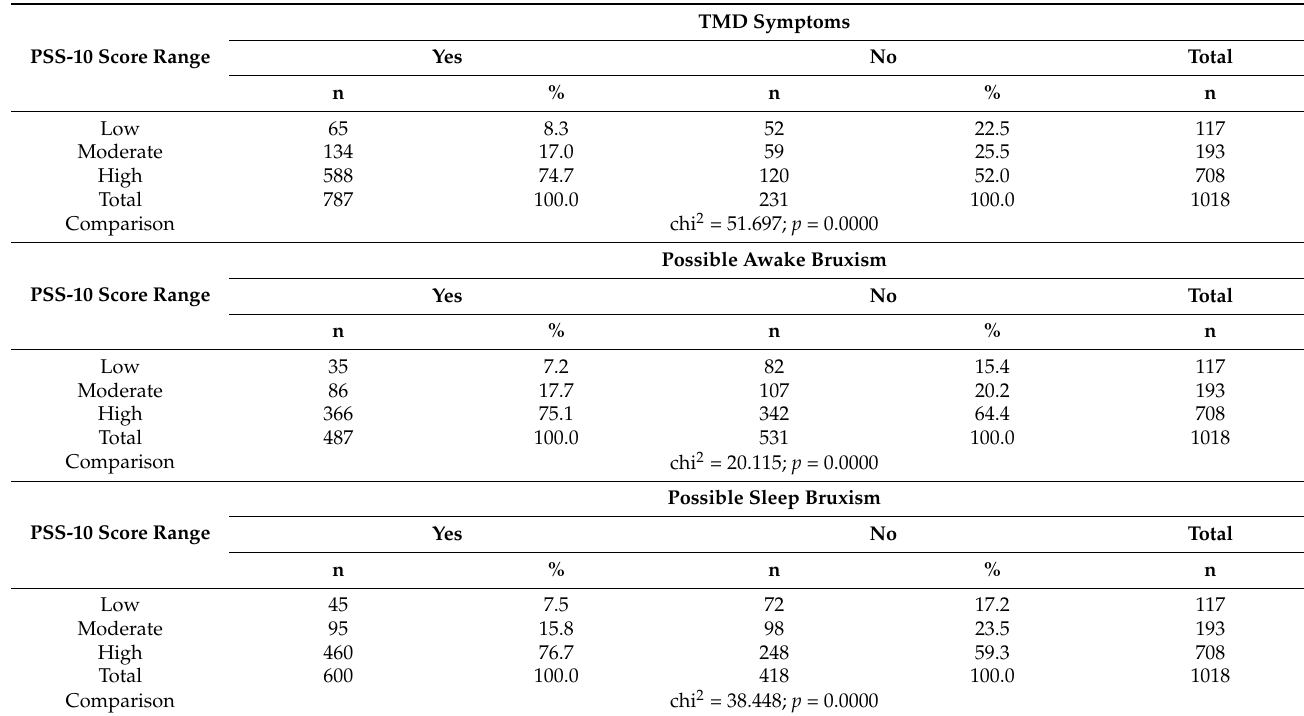
Table 2. The PSS-10 score ranges in subjects in the tested